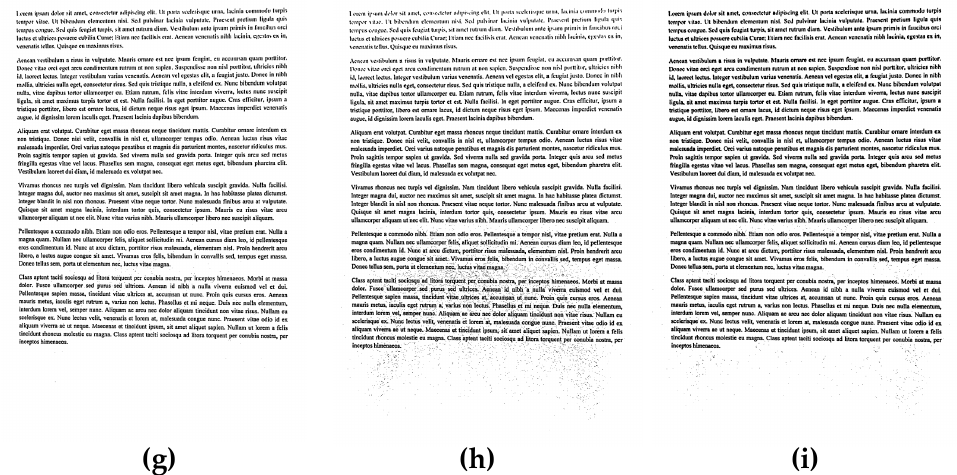
Figure 2. Binarization results obtained for a sample unevenly illuminated image from the dataset used in the experiments shown in Figure 1a for various methods: ( a ) Otsu, ( b ) Niblack, ( c ) Sauvola, ( d ) Bradley (mean), ( e ) Bernsen, ( f ) Meanthresh, ( g ) NICK , ( h ) stack of regions (16 layers), and ( i ) proposed (#51).